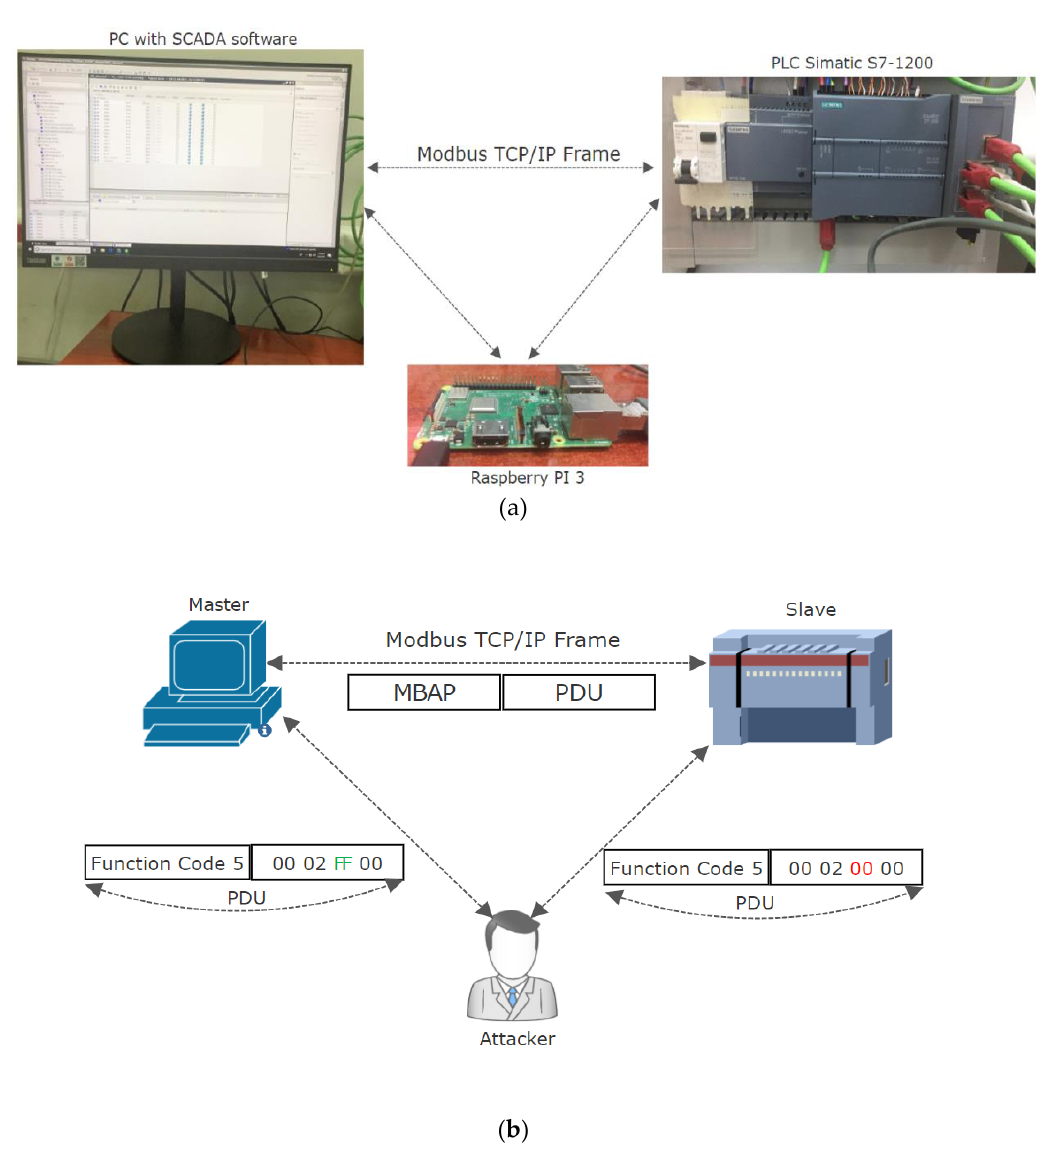
Figure 1. MITM (Man-In-The-Middle) physical setup and results of the attack. ( a ) Real setup for deploying the attack. ( b ) MITM resulted in Modbus TCP request message altering.